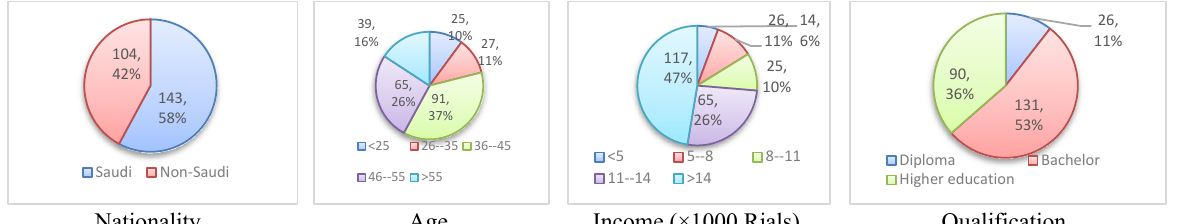
Fig. 2. Demographic characteristics of the Sample